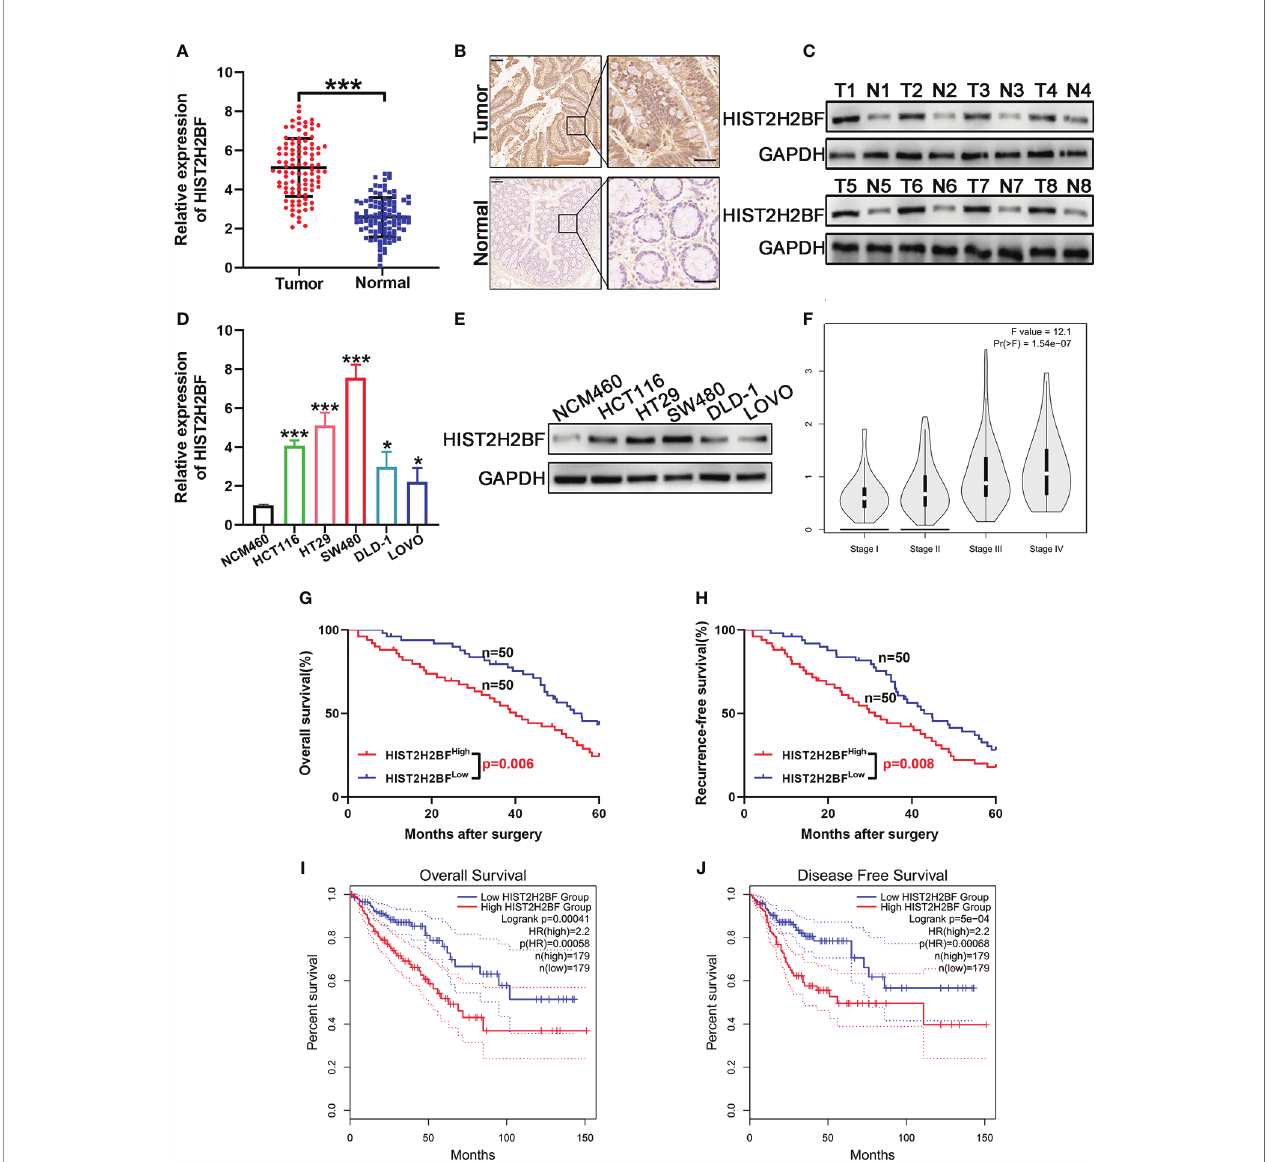
FIGURE 1 | HIST2H2BF was overexpressed in CRC and relates to poor prognosis in patients with CRC. (A) HIST2H2BF mRNA levels were determined in 100 paired CRC and adjacent normal tissues using real-time PCR. (B) Representative images of HIST2H2BF expression analyzed by immunohistochemistry in paired CRC and adjacent normal tissues. Scale bars, 100 m m. (C) Western blotting of HIST2H2BF expression in paired CRC and adjacent normal tissues (n = 8). (D) The expression levels of HIST2H2BF mRNA in fi ve CRC cell lines (LOVO, HCT116, DLD-1, HT29, and SW480) and the human normal colon epithelial cell NCM460 were detected using real-time PCR. (E) The expression levels of HIST2H2BF protein in CRC cell lines and NCM460. (F) The rxpression levels of HIST2H2BF in different stages of CRC in the GEPIA database using TCGA data. (G, H) The Kaplan-Meier OS (G) and RFS (H) curves of patients with CRC with high (n = 50) and low (n = 50) expressions of HIST2H2BF mRNAs in 100 paired CRC and adjacent normal tissues, respectively. (I, J) The Kaplan-Meier OS (I) and RFS (J) curves of patients with CRC with high (n = 179) and low (n = 179) expressions of HIST2H2BF mRNAs, respectively, in the GEPIA database using TCGA data. *P < 0.05, ***P <